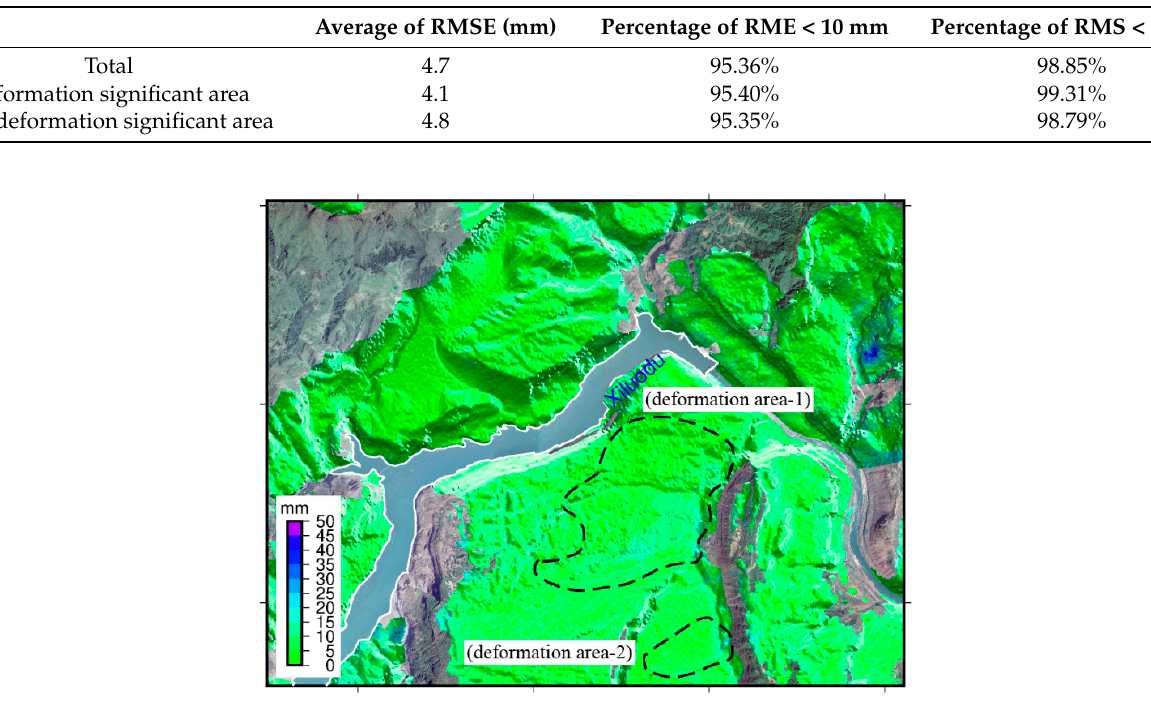
Figure 13. Root mean square error chart. ( a ) Total mean square error; ( b ) deformation significant regional mean square error; ( c ) deformation non-significant area mean square error. Table 2. RMS data statistics.